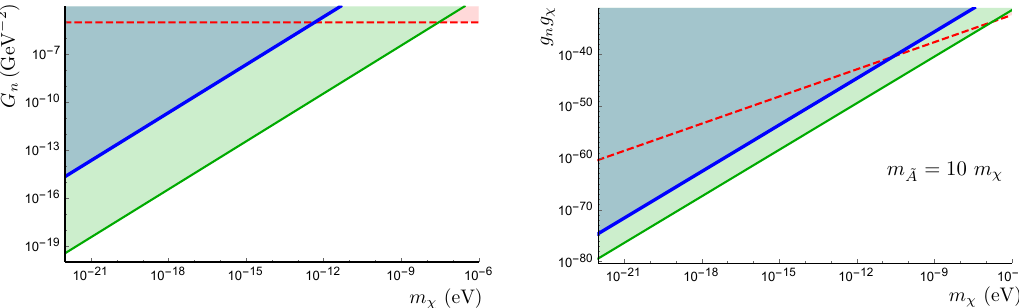
Figure 7 . Left: expected constraints on DM-neutron coupling G n g n g χ /m 2 for the scalar ˜ A ≡ 0 . 1 GeV) from atomic clocks –thick-solid (blue) line —, DM case with a heavy mediator ( m ˜ A ≥ magnetometers — thin-solid (green) line —, and DM pair emission in stars — dashed (red) line. Right: expected bounds on the product of DM and neutron couplings of the mediator ˜ A with mass = 10 m χ ; same line color coding, with star cooling bound coming from ˜ A m ˜ A